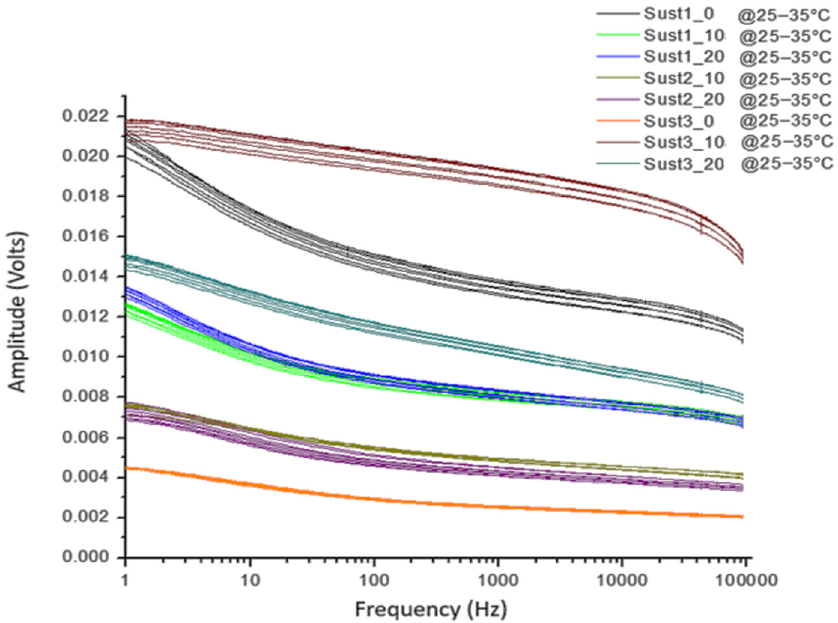
Figure 12. Phase results of the sensor response as a function of temperature.